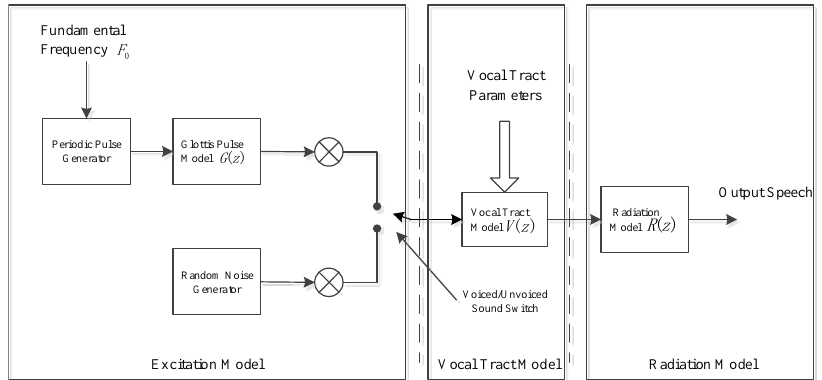
Figure 4. Discrete time-domain model of speech signal